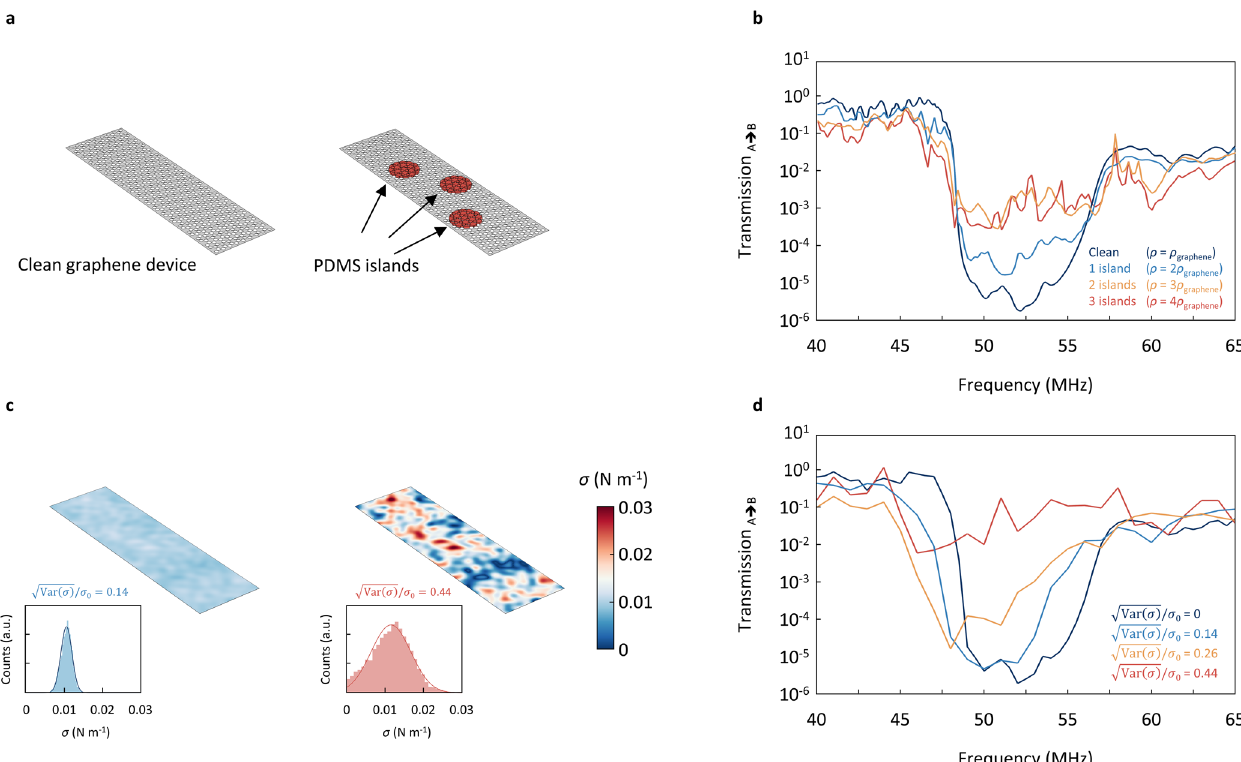
Fig. 4 The effect of disorder on the phononic bandgap. a A phononic device with and without surface contamination. b Phononic bandgap vs. added mass. With increasing degree of contamination, the bandgap smears out, yet remains visible up to areal mass density of ρ 2D (cid:5) 4 ρ graphene . c Graphene membrane before patterning with small and large tension disorder. The insets show the histograms used to extract the disorder ffiffiffiffiffiffiffiffiffiffiffiffiffi p ffiffiffiffiffiffiffiffiffiffiffiffiffi p = σ ¼ 0 : 14 and right, = σ ¼ 0 : 44 . d Phononic bandgap vs. tension disorder. At a critical relative variation in tension ffiffiffiffiffiffiffiffiffiffiffiffiffi Var σ ð Þ Var σ ð Þ strength: left, p 0 0 (cid:5) 0 : 40 the bandgap = σ Var σ ð Þ 0